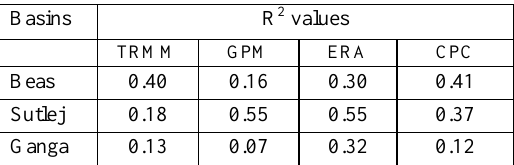
Table 1. Correlation coefficients for different products compared with reference